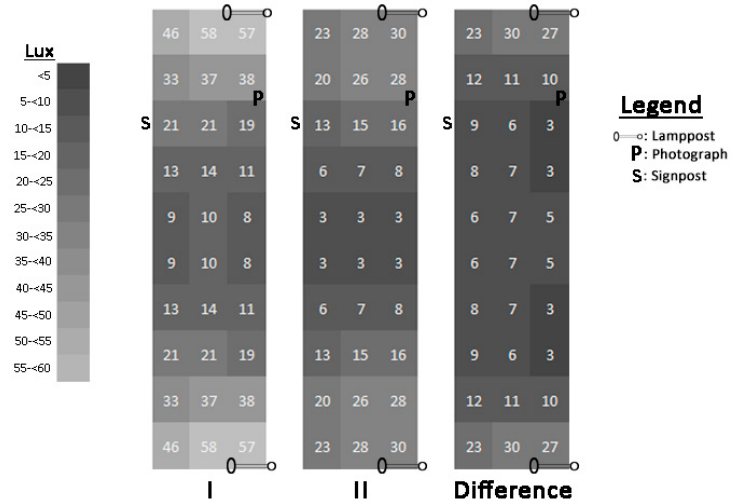
Figure 2. Horizontal illuminance distribution on the path (lx) for lighting applications I and II. The lampposts were located on the right-hand side, at the start and end of the depicted segment of the path. The measurements were conducted from midpoint to the second lamppost and extrapolated for illustrative purposes.